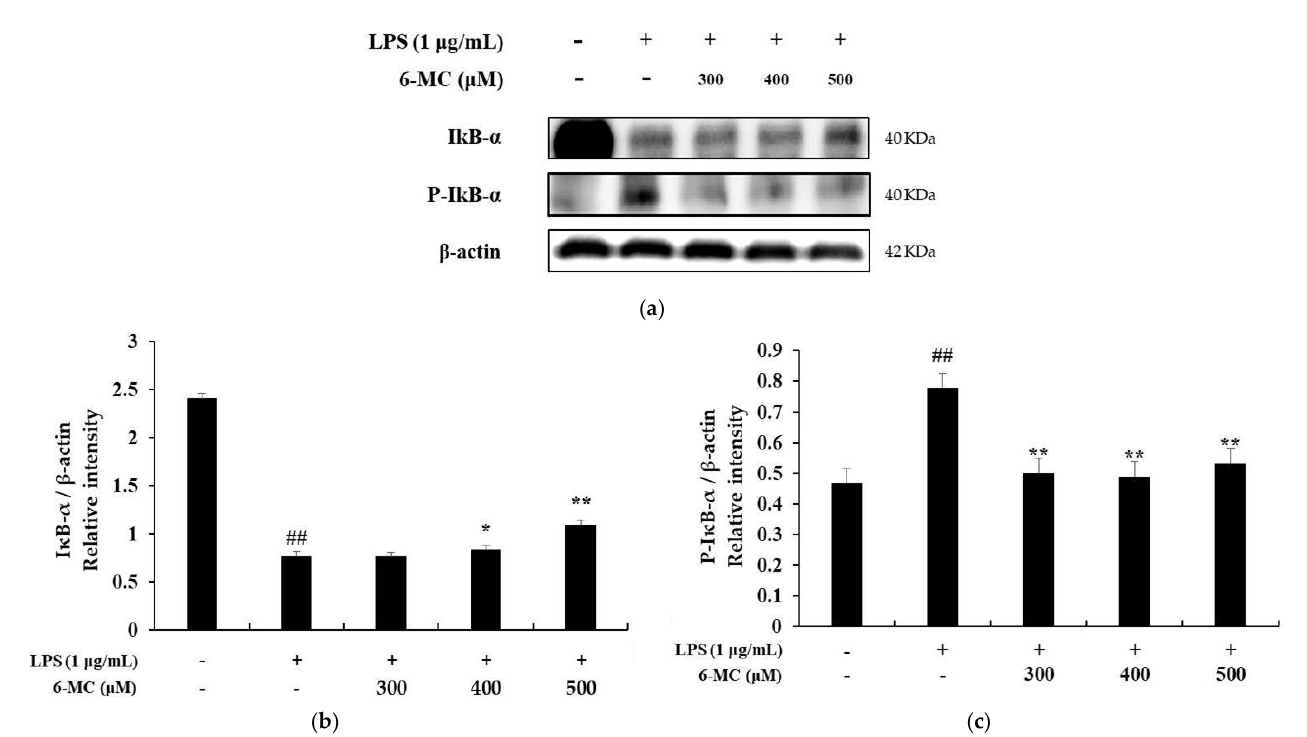
Figure 7. Effect of 6-MC on the protein expression level of P-IκB-α and IκB-α in LPS-induced RAW 264.7 cells. ( a ) Result of Western blotting, and protein level of ( b ) IκB-α and ( c ) P-IκB-α. Lysates were prepared from cells pretreated with 6-MC (300, 400, and 500 μM) for 1 h and then treated with LPS (1 μg/mL) for 20 min. β-actin was used as a loading control. Total cellular proteins were separated using SDS-PAGE, transferred to PVDF membranes, and detected using specific antibodies against phospho-IκB-α, IκB-α, and β-actin. The results in the graphs are presented as the mean ± SD from three independent measurements using the ImageJ program. ## p < 0.01 vs. untreated control group. * p < 0.05, ** p < 0.01 versus group treated with LPS alone.